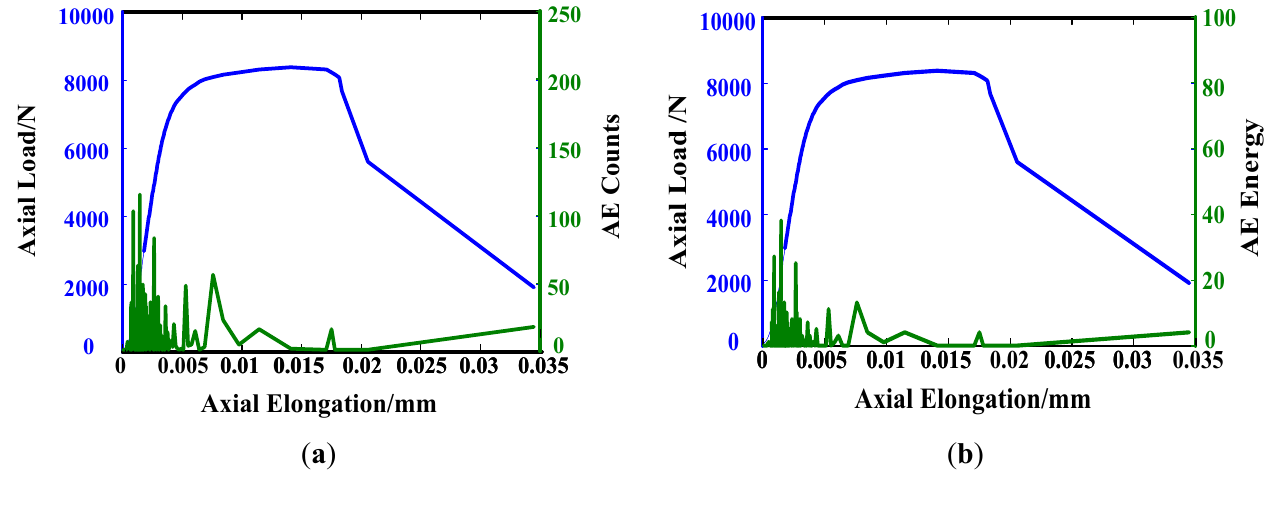
Figure 5. Acoustic emission (AE) signal and axial elongation curve. ( a ) Ring-down count and axial elongation curve; ( b ) Energy and axial elongation